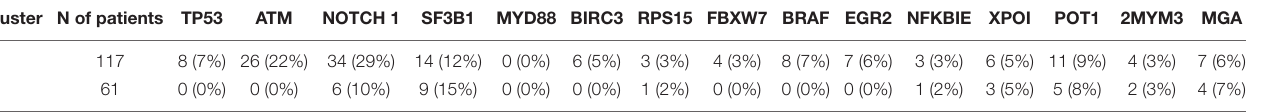
FIGURE 5 | Patients with unmutated IGHV only. (A) Kaplan–Meier curves depicting TTFT for patients within different prognostic subtypes. (B) The 10 most important pathways characterizing individual clusters of the classification model. Pathway importance was ranked by its information gain, which corresponds to the relative contribution of the feature to a prediction. The first word in a pathway name denotes a database from which a feature originates. Shades of blue represent clustered pathway signatures that have similar importance values. TABLE 4 | Distribution of common CLL driver genes between the clusters identified within the unmutated IGHV subgroup. Cluster N of patients